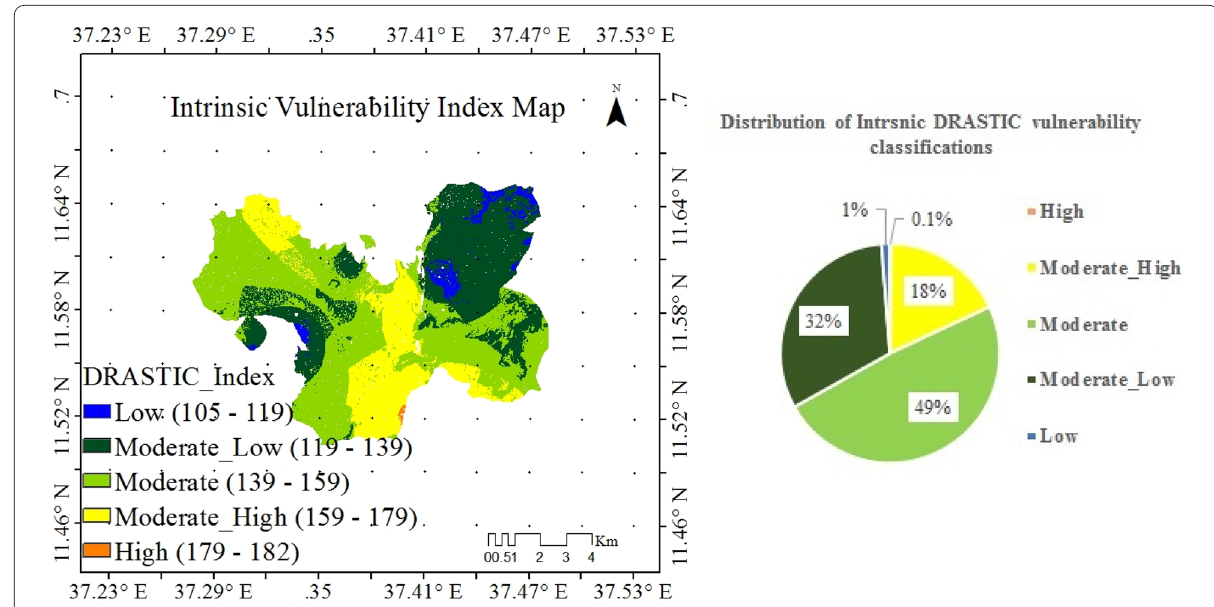
Fig. 4 Intrinsic DRASTIC Index (left) and Area Percentage Distribution